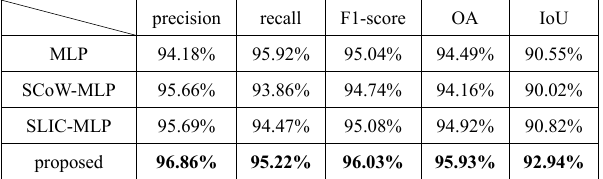
Table 2. Evaluation of vegetation detection on UAV images dataset. Best results are highlighted in bold font.